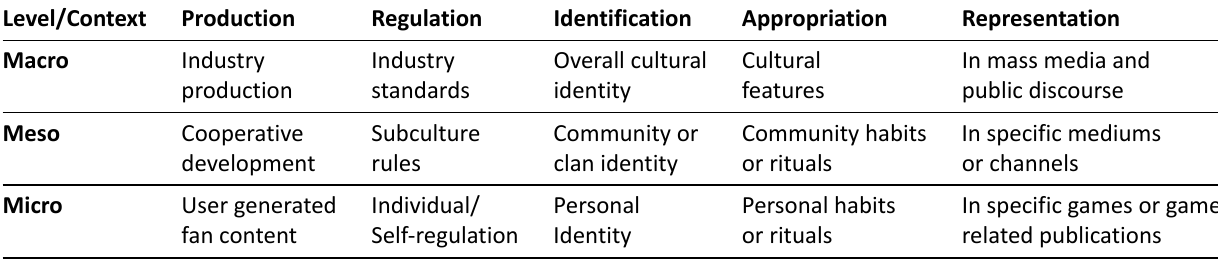
Table 2. Manifestations of contextual phenomena on various